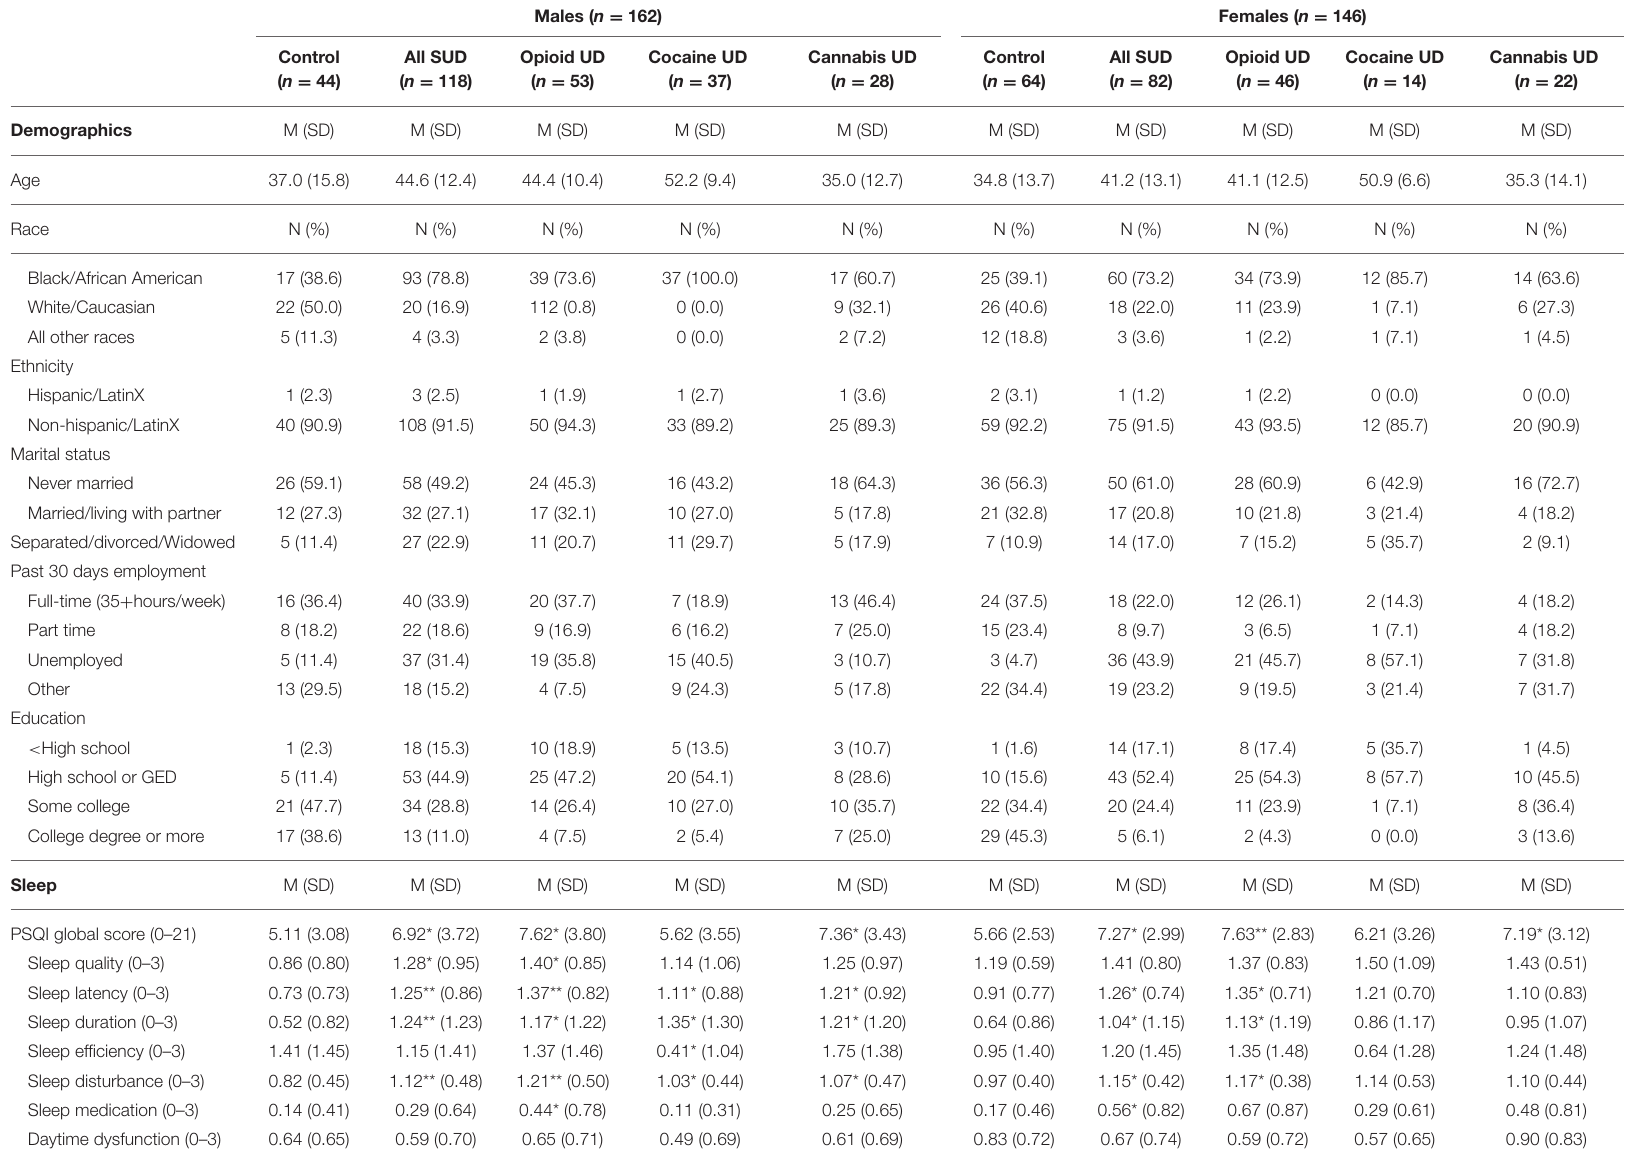
TABLE 1 | Demographic, clinical, and sleep characteristics of SUD and non-substance misusing control study participants.